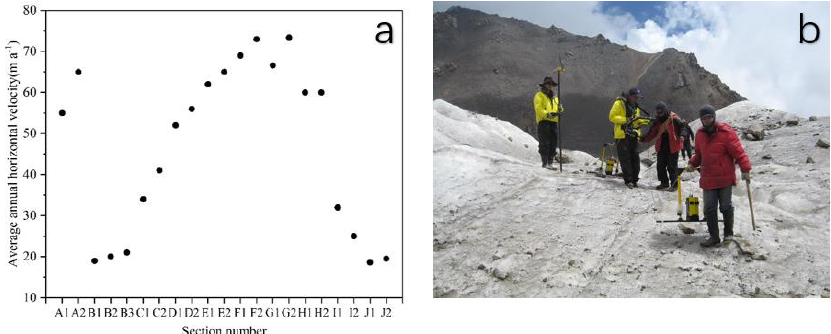
Figure 2. ( a ) Horizontal movement velocity of the GPS stakes and ( b ) GPR field